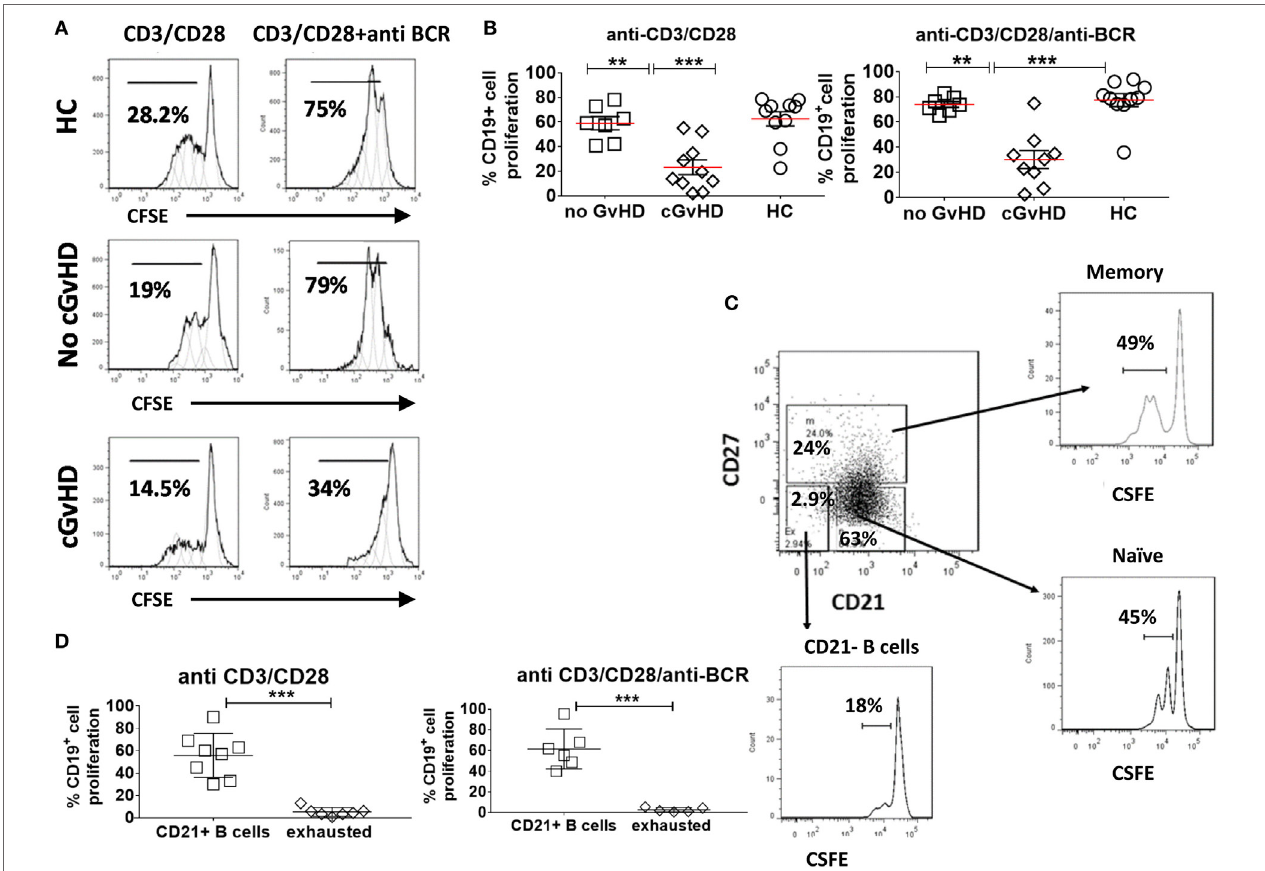
FigUre 4 | Proliferation of CD19 + B cell in response to B cell receptor (BCR) triggering and CD40L ligation. Carboxyfluorescein Succinimidyl Ester (CFSE)-stained peripheral blood mononuclear cells from healthy donors and patients with or without chronic graft-versus-host disease (cGvHD) were stimulated, anti-CD3/CD28 alone, or a combination of anti-BCR and anti-CD3/CD28 beads for 96 h. (a) Representative CFSE histograms comparing the proliferation of gated CD19 + B cells. (B) Comparison of B cell proliferation in 10 cGvHD patients, 7 no GvHD patients, and 10 healthy controls (HC). Chronic GvHD patients had the lowest proliferative potential in response to B cell stimulation compared with “no GvHD” patients and HC. (c) FACS plots of a representative cGvHD patient comparing the proliferation of CD27 + memory B cells and CD21 + CD27 − naïve B cells with CD21 − B cells. (D) CD21 − B cells proliferated significantly less than the rest of B cells ( n = 8) when compared using non-parametric t -test p < 0.001